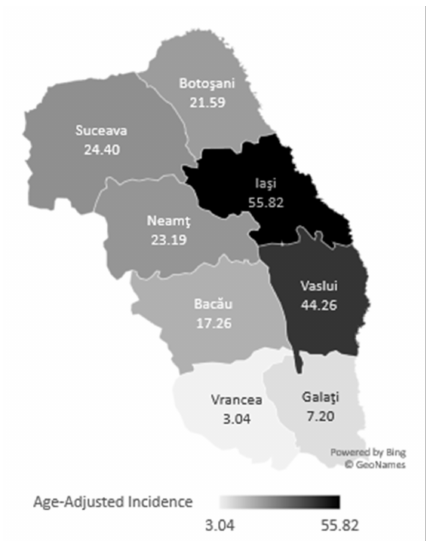
Figure 2. Age-adjusted thyroid carcinoma incidence in North East counties of Romania [12]. Age-adjusted incidence was obtained using public statistical data obtained from the Romanian National Institute of Statistics using interrogations on Tempo Online Plat- form